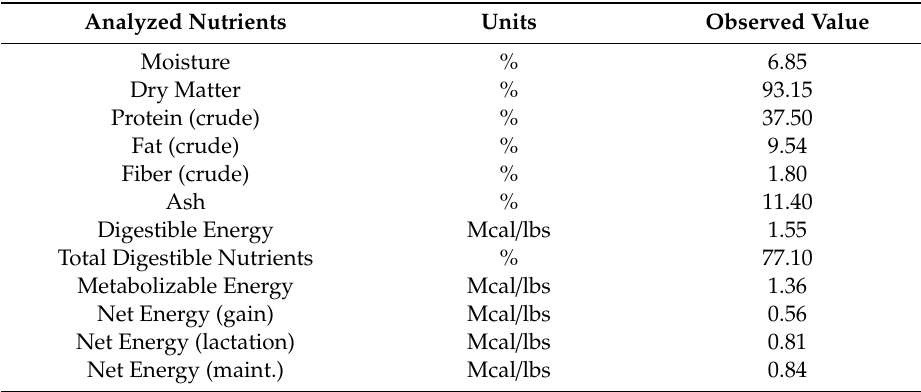
Table 1. Proximate analysis for proprietary diet fed to all research